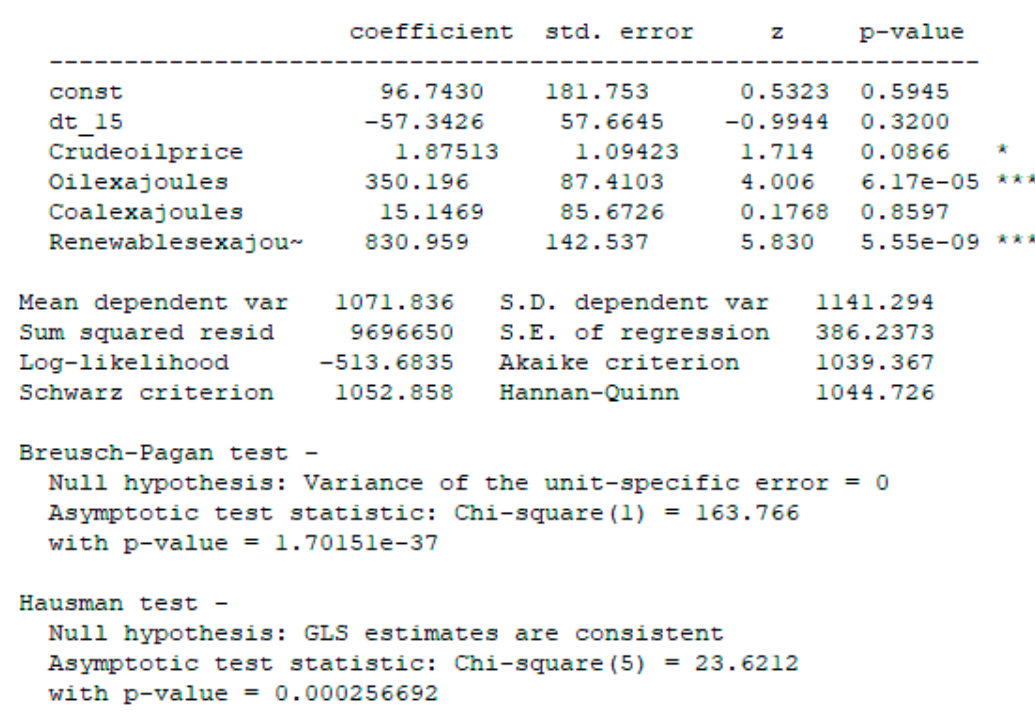
Figure 13. Random E ff ects model. Figure 13. Random Effects